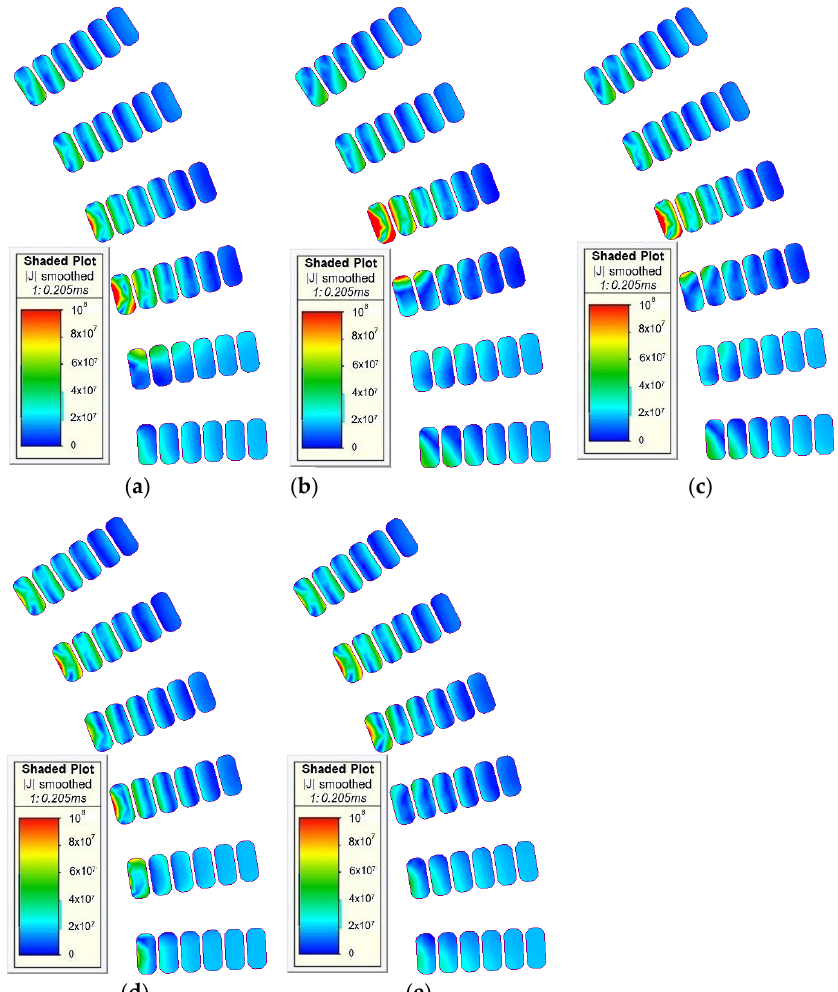
Figure 14. Instantaneous current density at the intersection frequency point in steady-state condition for the five rotor topologies, ( a ) First topology (SMPMSM), ( b ) Second topology, ( c ) Third topology (magnets embedded in the core), ( d ) fourth topology (the classical V shape), ( e ) fifth topology (the classical Δ shape) .